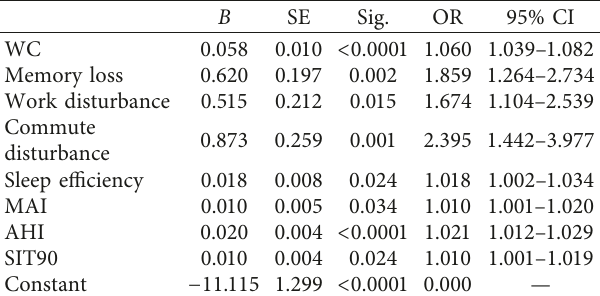
Table 4: Multivariate analysis of mild to moderate EDS by binary logistic regression.